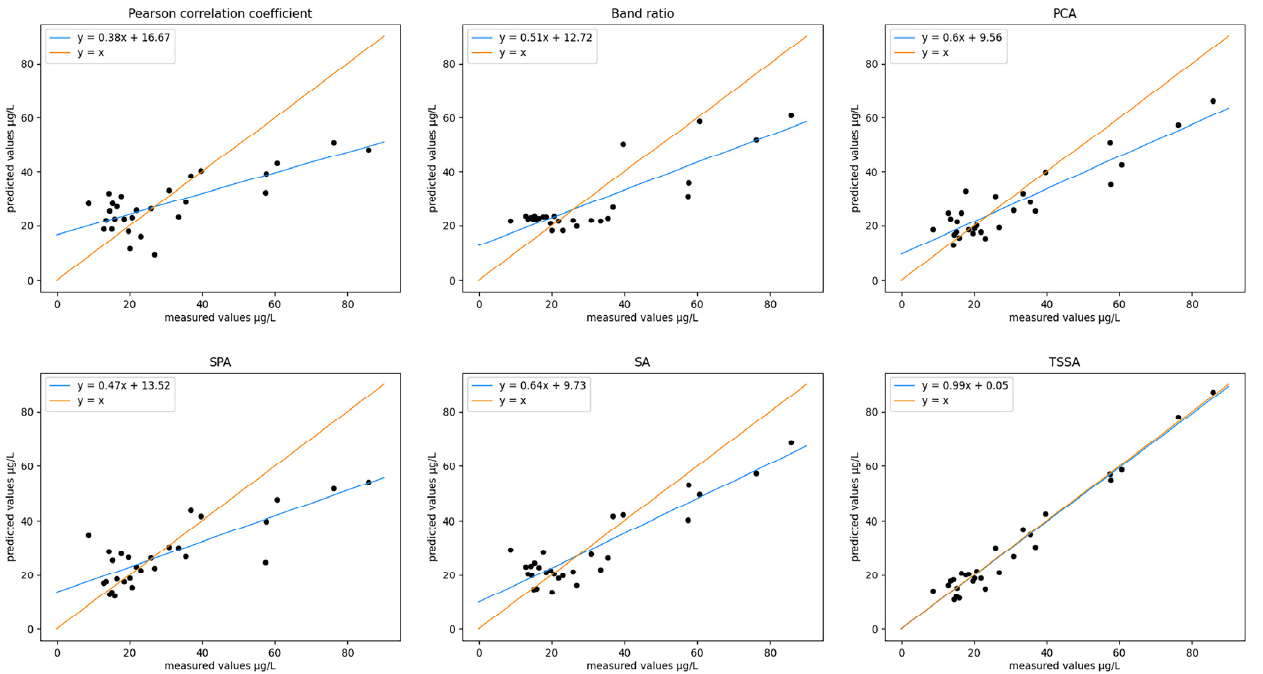
Figure 8. Comparisons of the measured and predicted values of the validation dataset using the results obtained from the six feature extraction methods for modeling predictions.